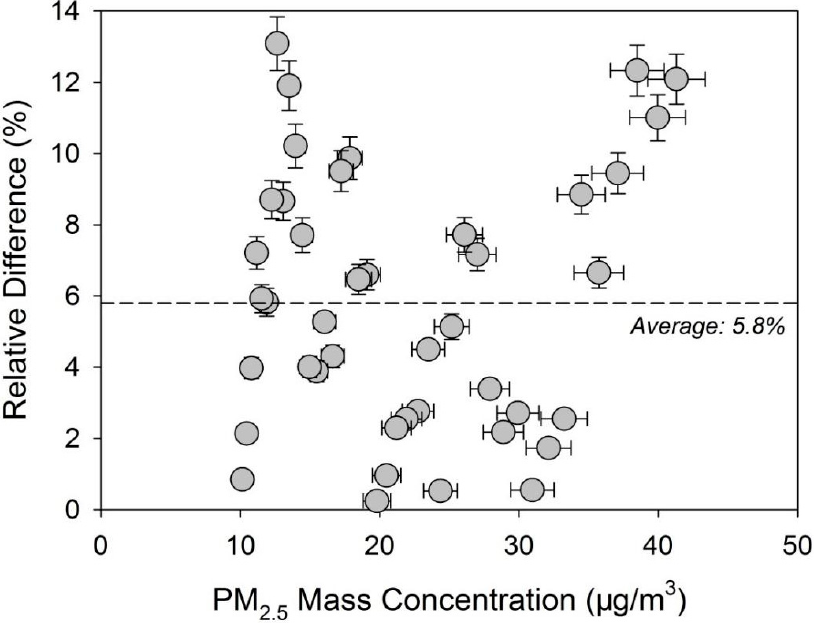
Figure 7. Relative difference measured by the TEOM and calibrated Dusttrak Model 8530.